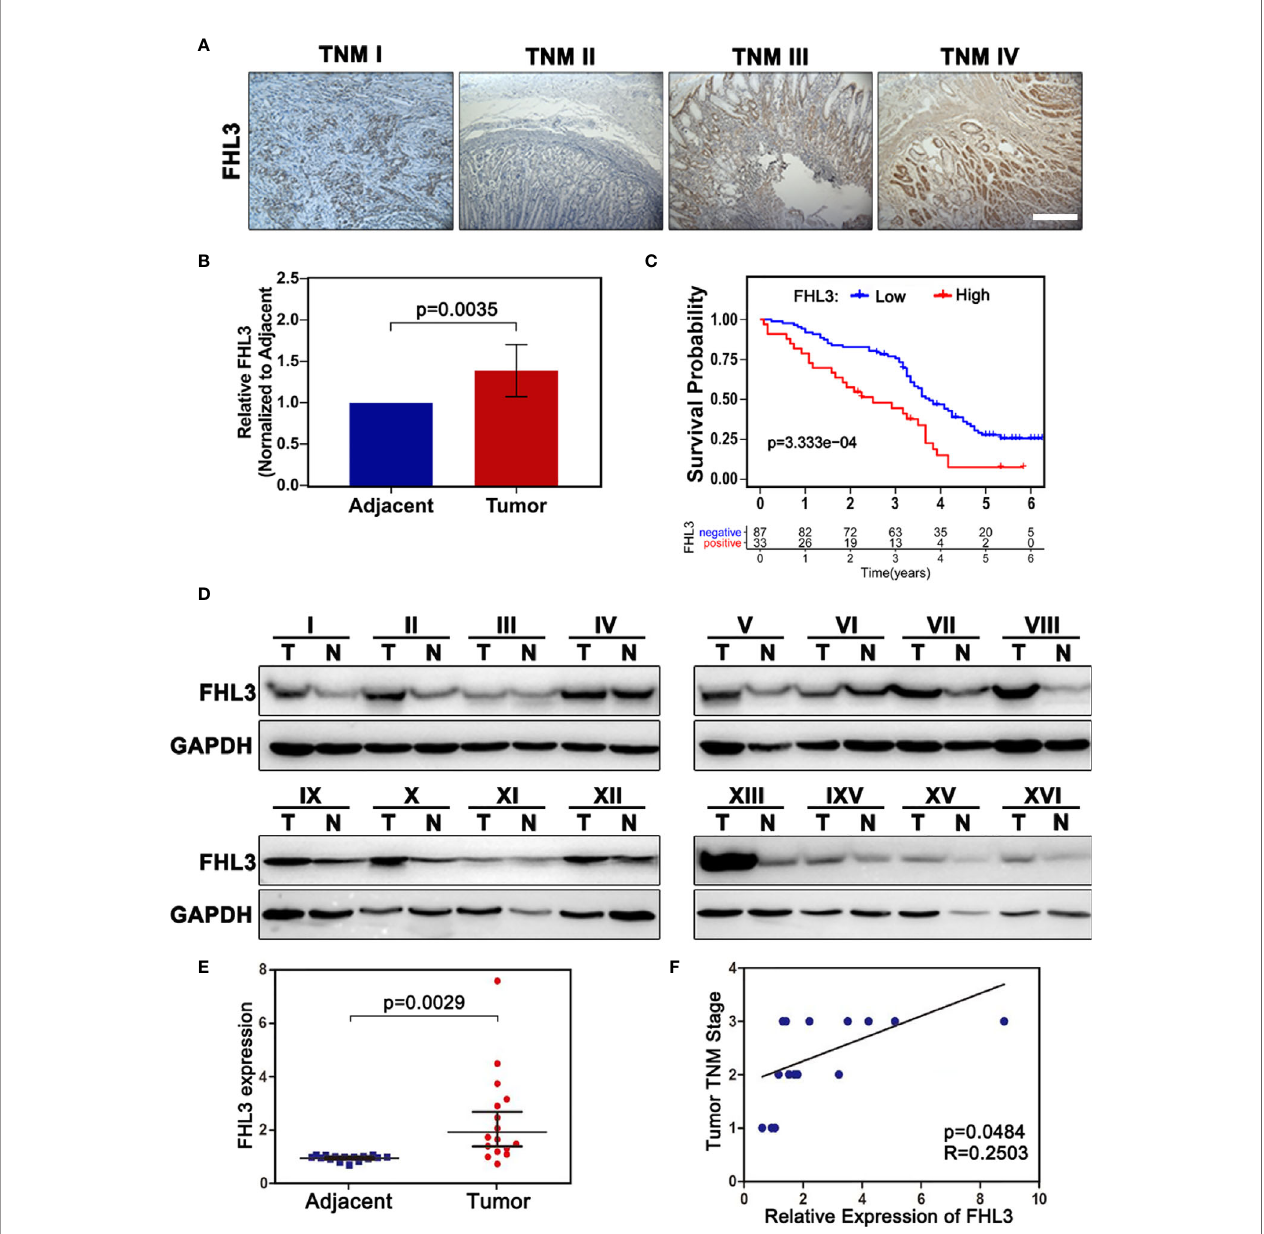
FIGURE 2 | FHL3 is highly expressed in tumor samples, FHL3 expression, and associated with survival and TNM stage. The level of FHL3 in gastric cancer was analyzed in 16 fresh frozen tumor tissues and 120 paraf fi n-embedded sections (40× magni fi cation). (1) FHL3 expression level in different TNM stages of gastric cancer (A) ; (2) Relative FHL3expression level in cancer when compared with adjacent tissues (B) ; (3) Kaplan – Meier analysis of 120 gastric cancer patients (C) ; similar conclusion was found that higher FHL3 expression always means poor overall survival; (4) Western blot result of 16 fresh frozen tumor tissues and its adjacent tissues (D) ; (5) Semi-quantitation analysis of western blot result of 16 fresh frozen tumor tissues and its adjacent tissues (E) ; Relationship between FHL3 and TNM stage (F)